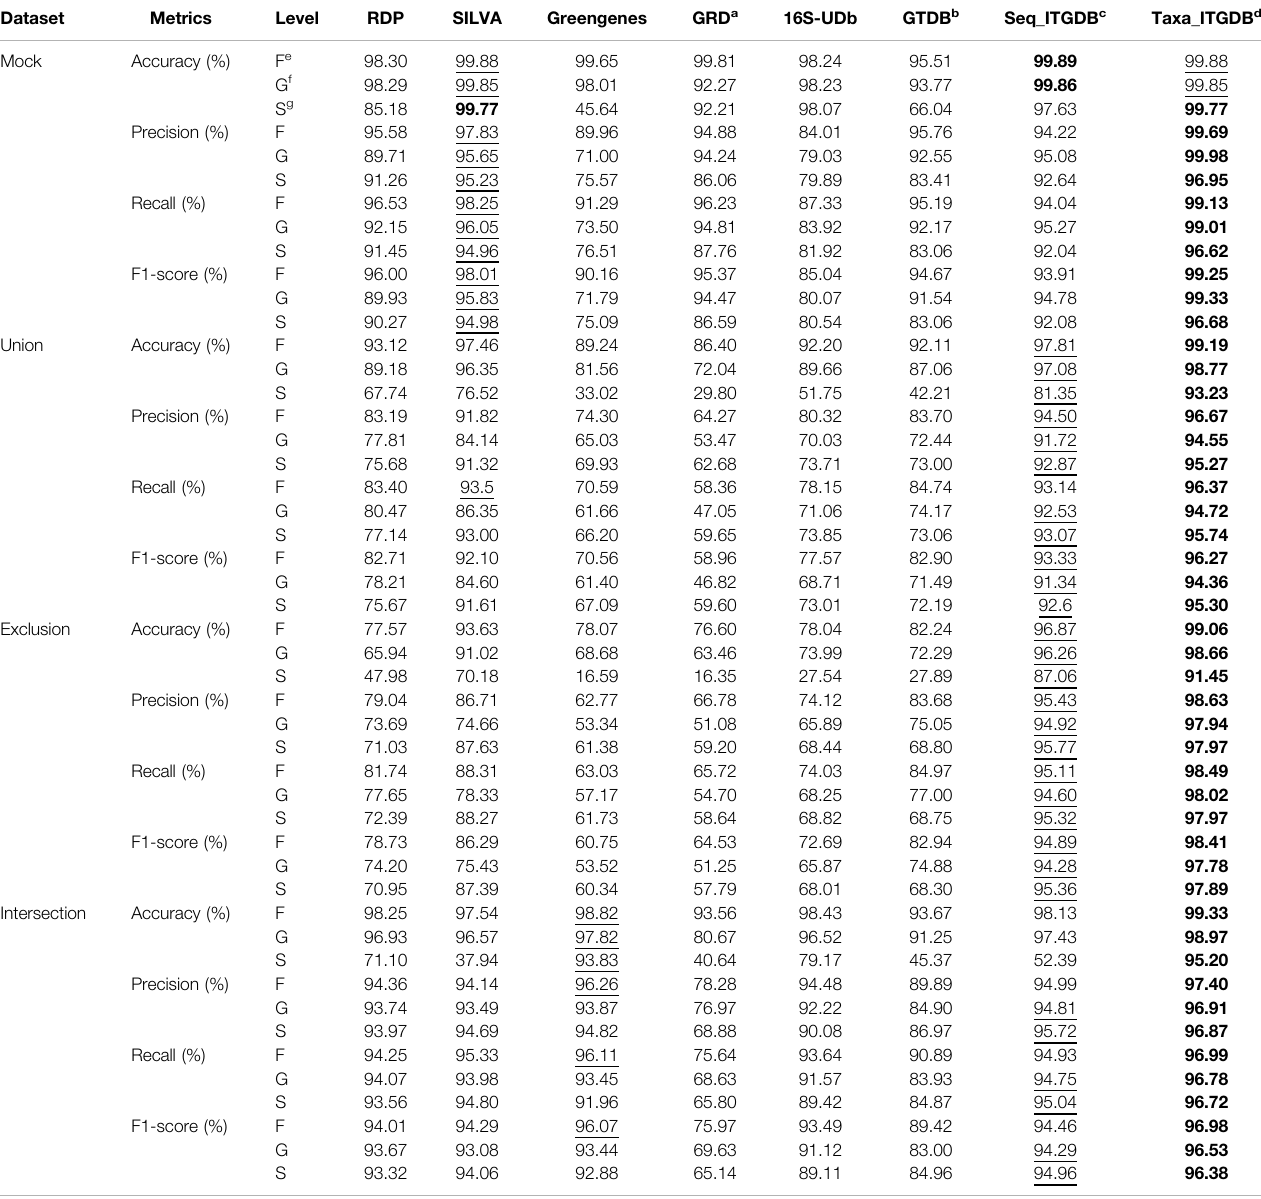
TABLE 2 | Performance comparison between different 16S rRNA databases. The bold font and underline symbol indicate the highest and the second highest value, respectively. Dataset